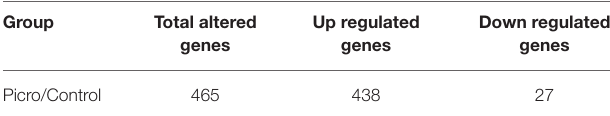
TABLE 1 | Number of genes whose expression was altered by picrotoxin